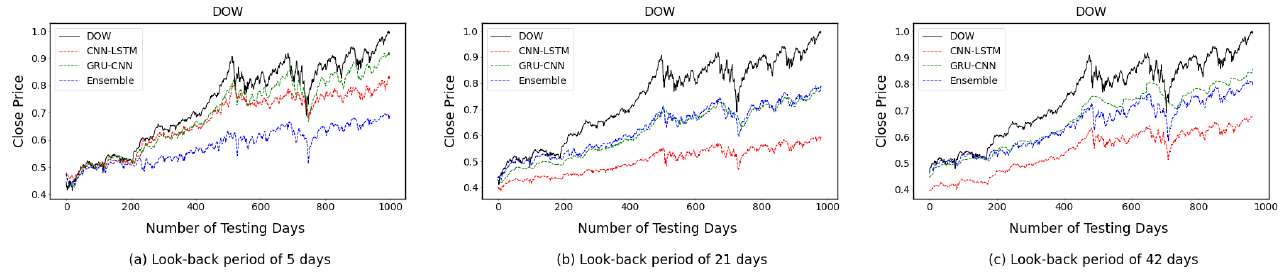
Figure 10. Comparison of true and predicted close prices of the DOW index between different look-back periods for five-time-step prediction over the period from 1 January 2000 through 31 December